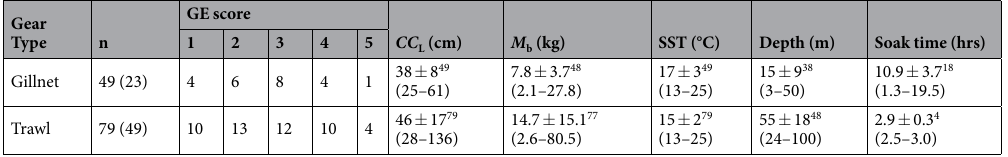
Table 1. Numbers of examined bycaught sea turtles by gear type, detection of gas embolism (GE, shown in parentheses following total n examined), severity of GE based on a score of 1–5, and average curved carapace length ( CC L ), body mass ( M b ), sea surface temperature (SST), depth and estimated gear deployment time (with standard deviation and range). Superscripted values are number of